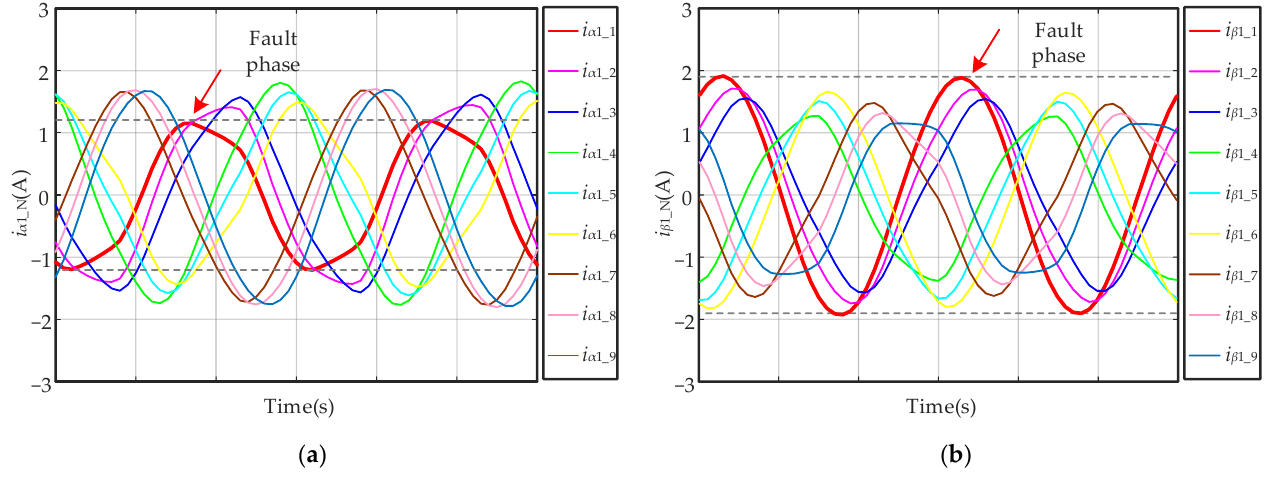
Figure 9. ( a ) i α 1_ N in loss signal fault; ( b ) i β 1_ N in loss signal fault. When i A1 = 0, the loss signal fault occurs in phase-A 1 . According to the Equation (7), among the nine i α 1_ N and i β 1_ N obtained by the axis rotation system, i α 1_1 is most affected and i β 1_1 keeps the amplitude almost constant. Thus, it can be seen in the Figure 8 that i α 1_1 becomes the current with the lowest amplitude, and conversely, i β 1_1 becomes the one with the highest